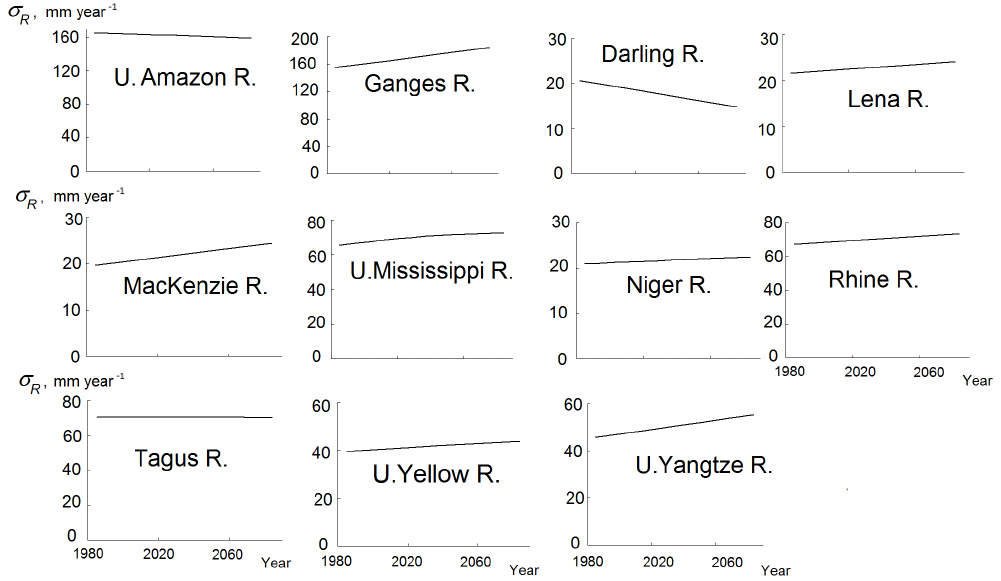
Figure 4. The dynamics of standard deviation of annual runoff σ R during the 21st century.